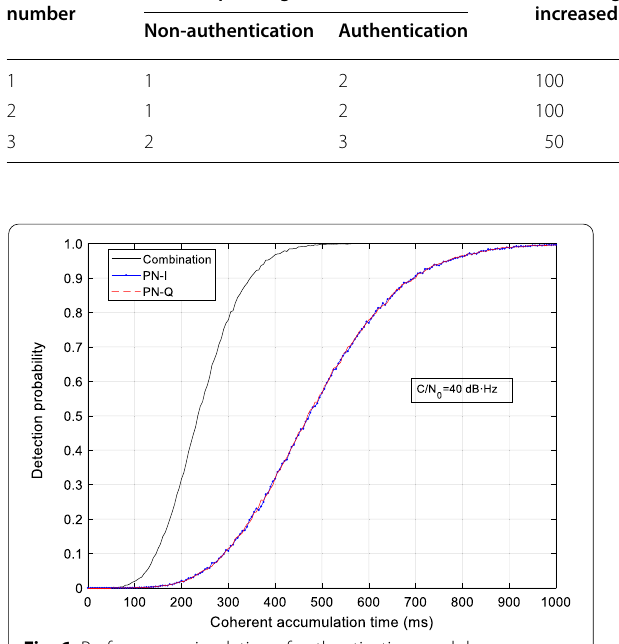
Fig. 6 Performance simulation of authentication module Fig. 7